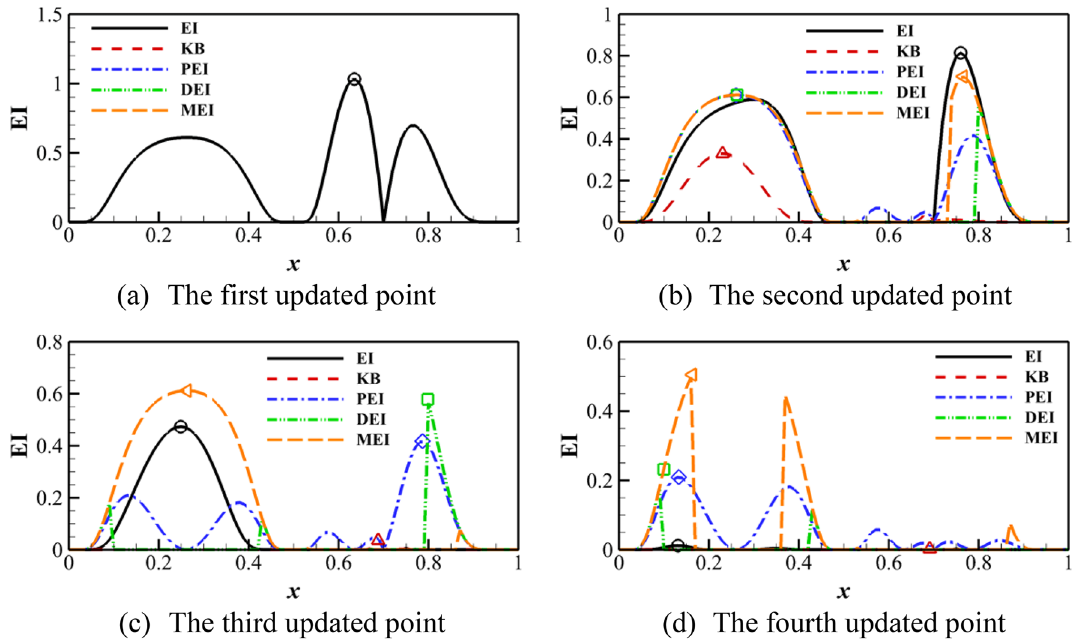
Figure 2. KB, PEI, DEI, and MEI algorithm on Forrester function compared with the standard EI algorithm.